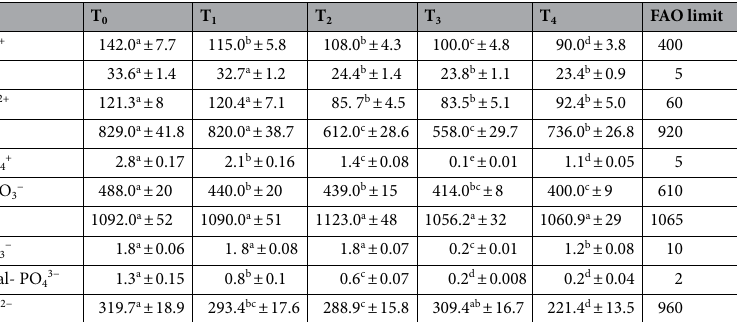
Table 1. Concentrations of soluble cations and anions in wastewater collected from each treatment unit. T 0 (untreated water), T1 (water after sedimentation unit), T 2 (water after sand & gravel beds), T 3 (water after reed + sand & gravel beds) and T 4 (water after biochar + sand & gravel beds). Similar letters indicate no significant variations among treatments. Mean with the same letter within rows are not significantly different at P <